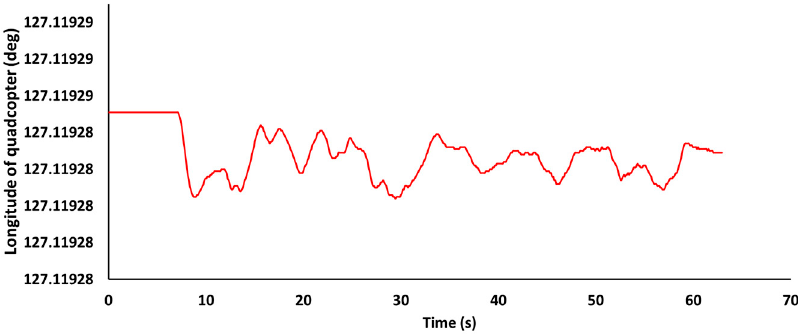
Figure 28. Latitude of the quadcopter during the vertical takeoff and landing.